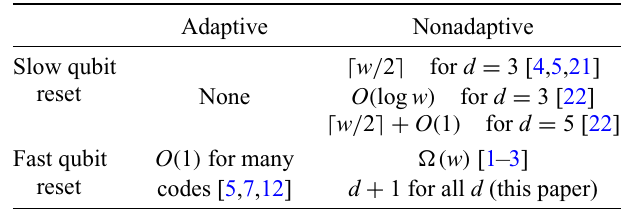
TABLE I. Numbers of ancilla qubits for different error- correction schemes. Here, d is the code distance and w is the maximum stabilizer generator weight. In Refs. [5], [7], and [12], flag patterns can only detect or reveal partial information about the correlated data errors; adaptive syndrome measure- ment is further needed for full correction. In Refs. [1–3], cor- related data errors cannot occur due to ancilla verification. In the other schemes in the table, syndrome-measurement circuits can be scheduled deterministically; (flag) ancilla patterns provide enough information to correct correlated